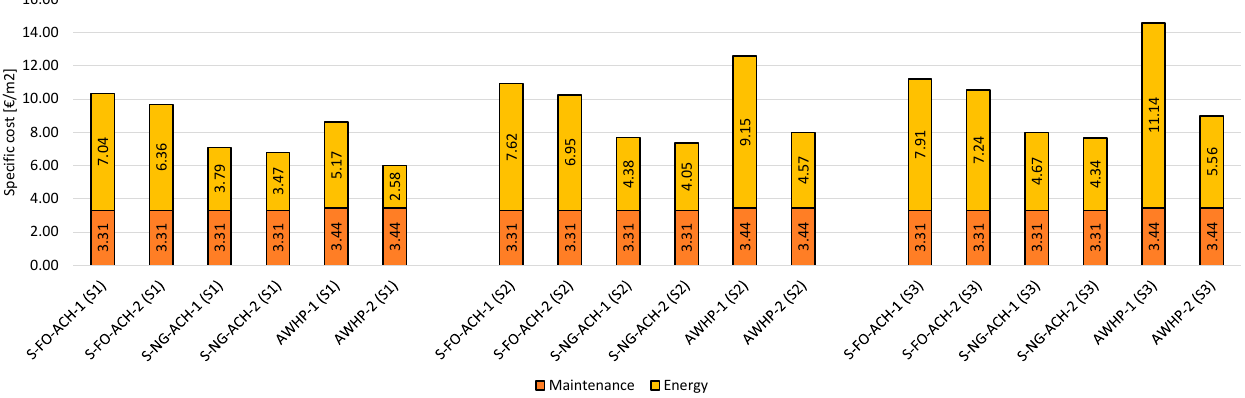
Figure 10. Maintenance and energy costs for HVAC systems operating in three scenarios of energy prices.